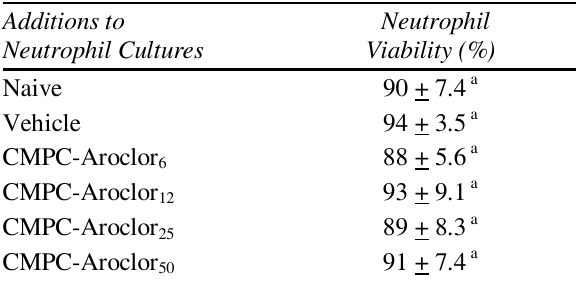
Table 3: Toxic Effect of Progenitor Cell-Derived Condtioned Medium on Neutrophil Cultures. Isolated neurophils (2 X 10 6 cells/mL) were incubated with or vehicle for 24 hrs. After CMPC-Aroclor (6, 12, 25 or 50 µM) this incubation, neutrophils were washed and viability was assessed by spectrophotometric analysis of LDH = CMPC- release and eosin Y uptake. Aroclor (X) = conditioned mediuM from PC treated with Aroclor (X) Aroclor, where (X) is the concentration of Aroclor; Values represent mean + S.E.M.; a, indicates values that are significant (p<0.05).